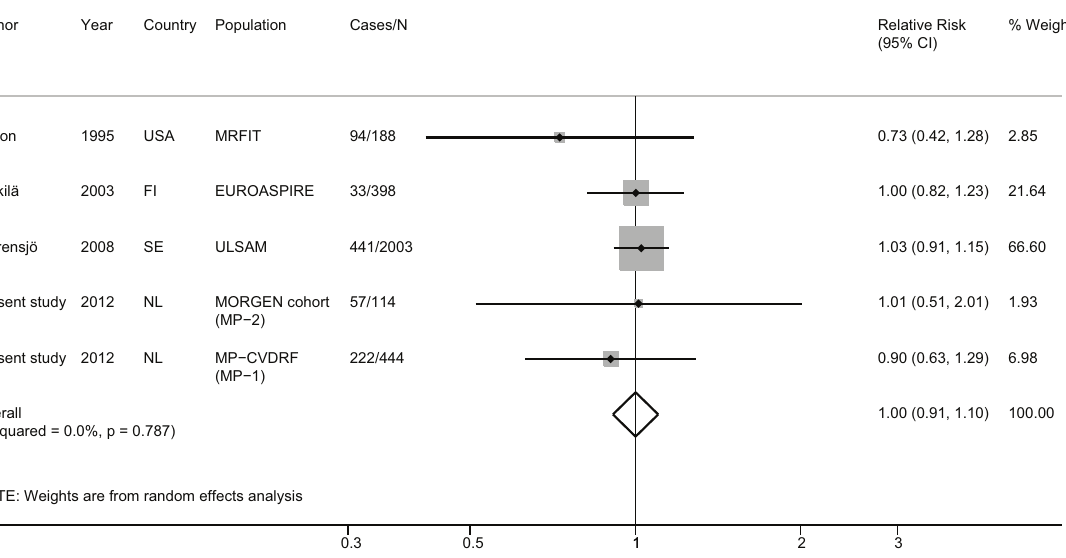
Figure 4. Pooled relative risk of cholesterol ester alpha-linolenic acid and CHD risk.